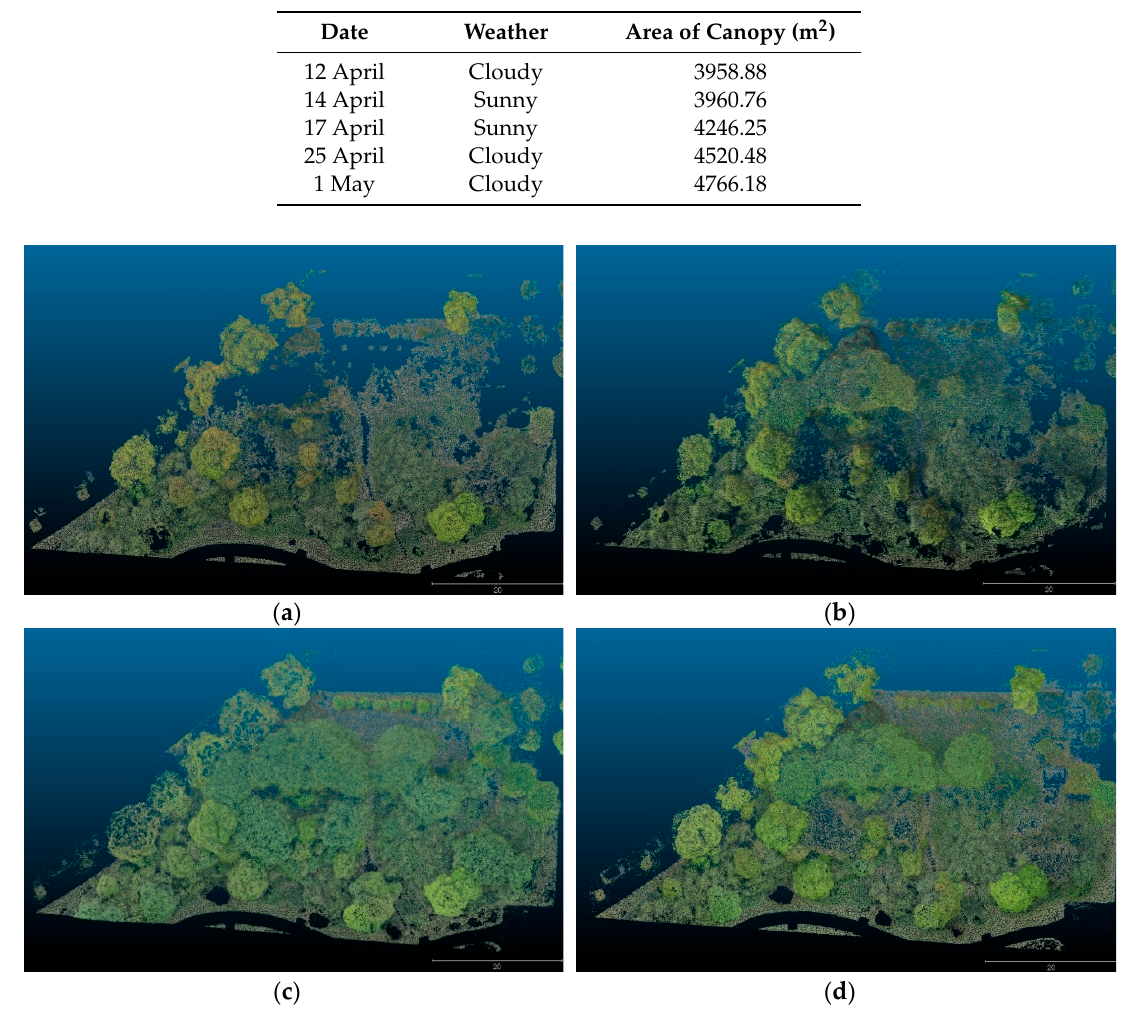
Figure 9. The comparison of the point cloud models of sakura trees in the selected area on 2 April ( a ), 8 April ( b ), 17 April ( c ), and 25 April 2019 ( d ). The point cloud models had been extracted by ExG index.